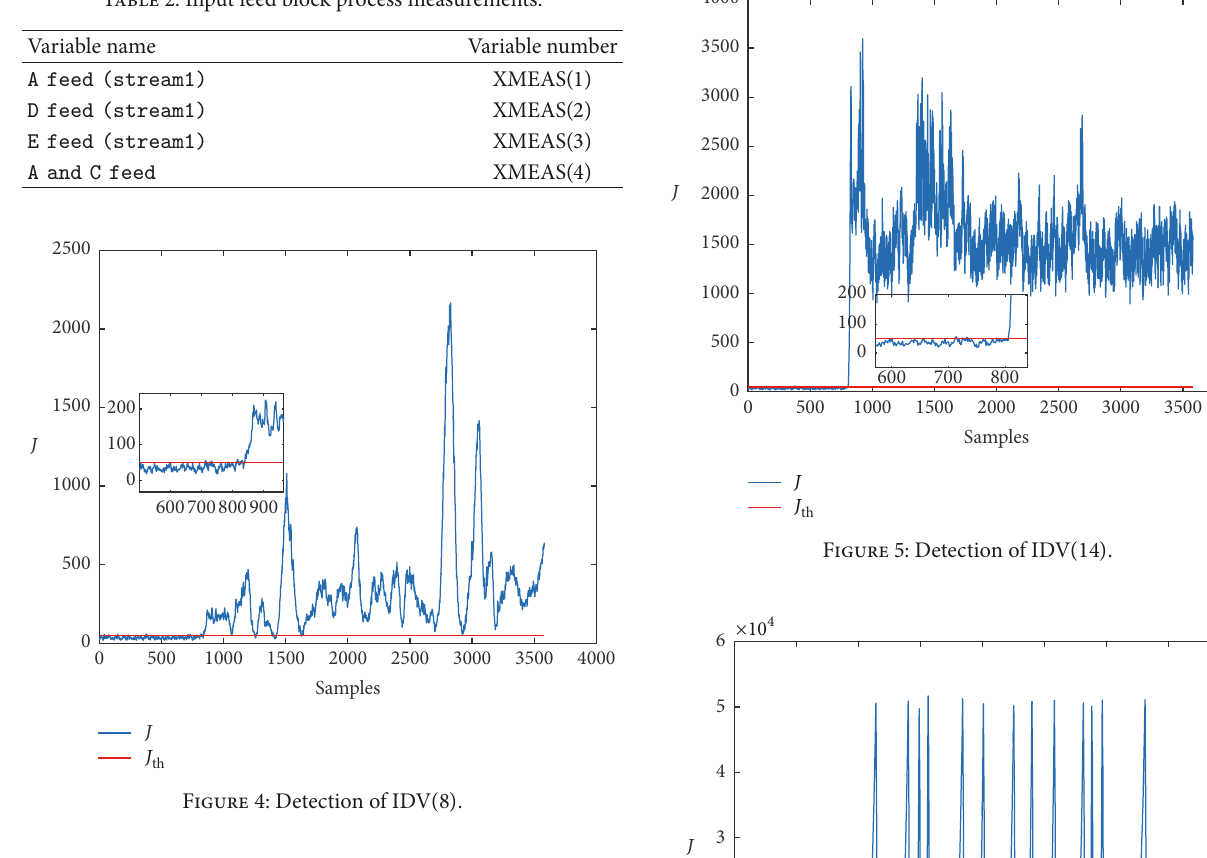
Table 2: Input feed block process measurements.